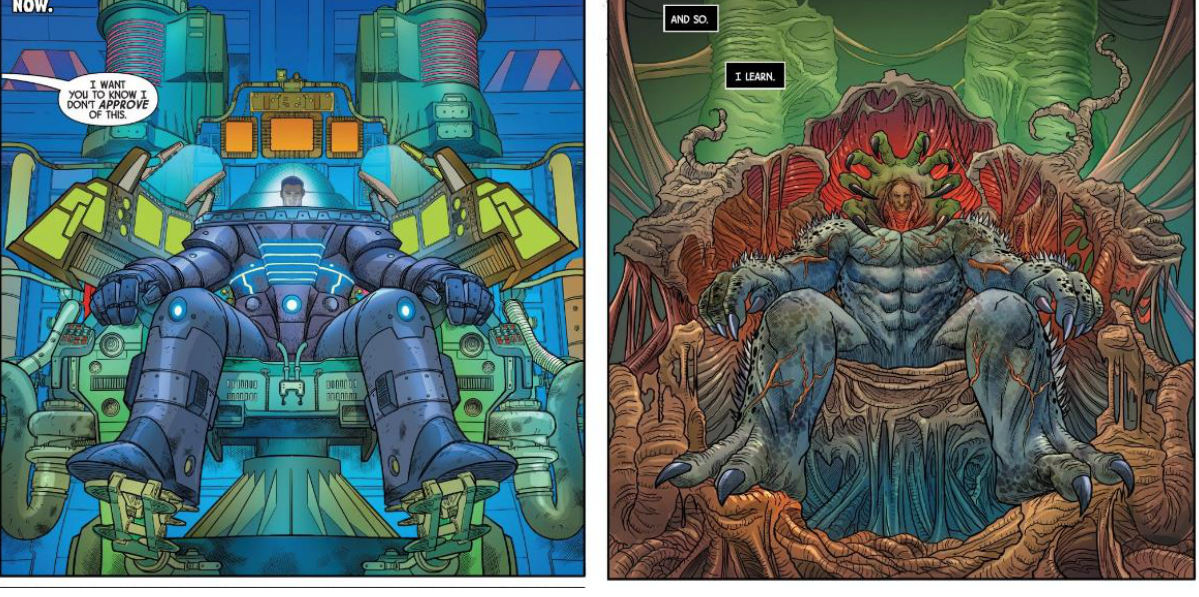
Figure 2. Fortean in (a) Immortal Hulk #5 and (b) Immortal Hulk #1, No.